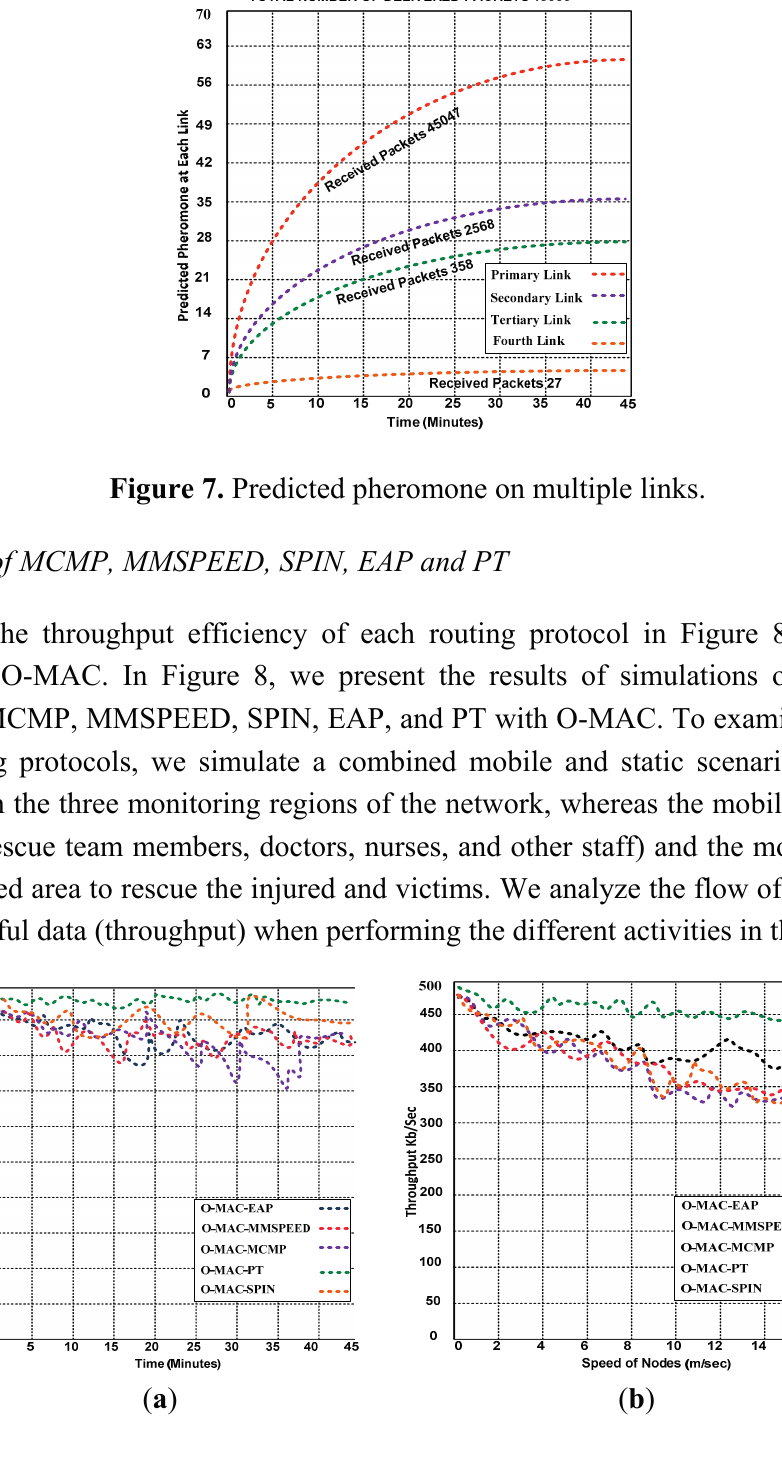
Figure 8. ( a ) Throughput when the nodes are all static and ( b ) Throughput when 50% of the nodes are